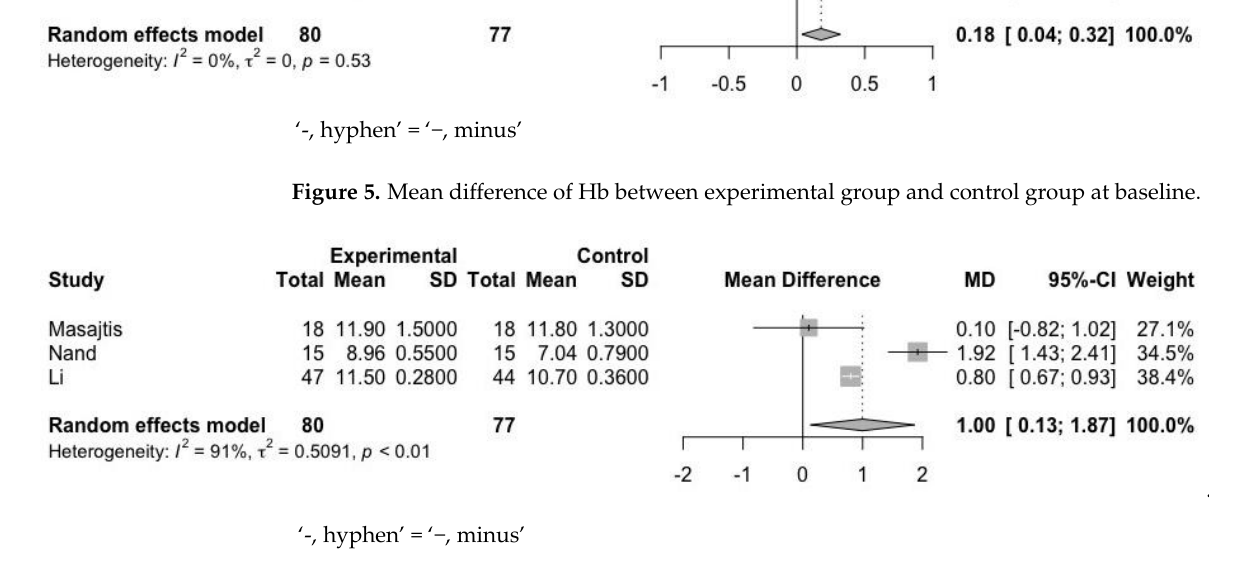
Figure 6. Mean difference of Hb between experimental group and control group at endpoint.